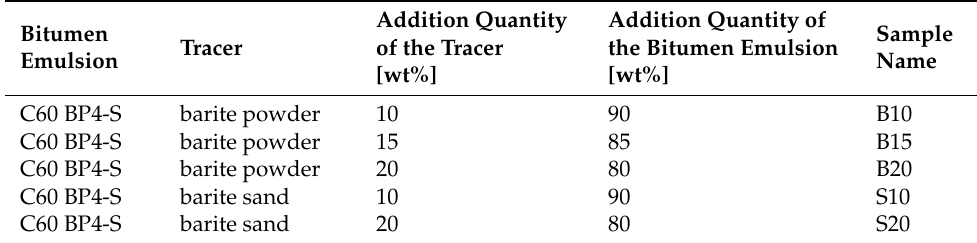
Figure 10. Schematic drawing of the material preparation. Table 3. Addition quantities of the tracers.